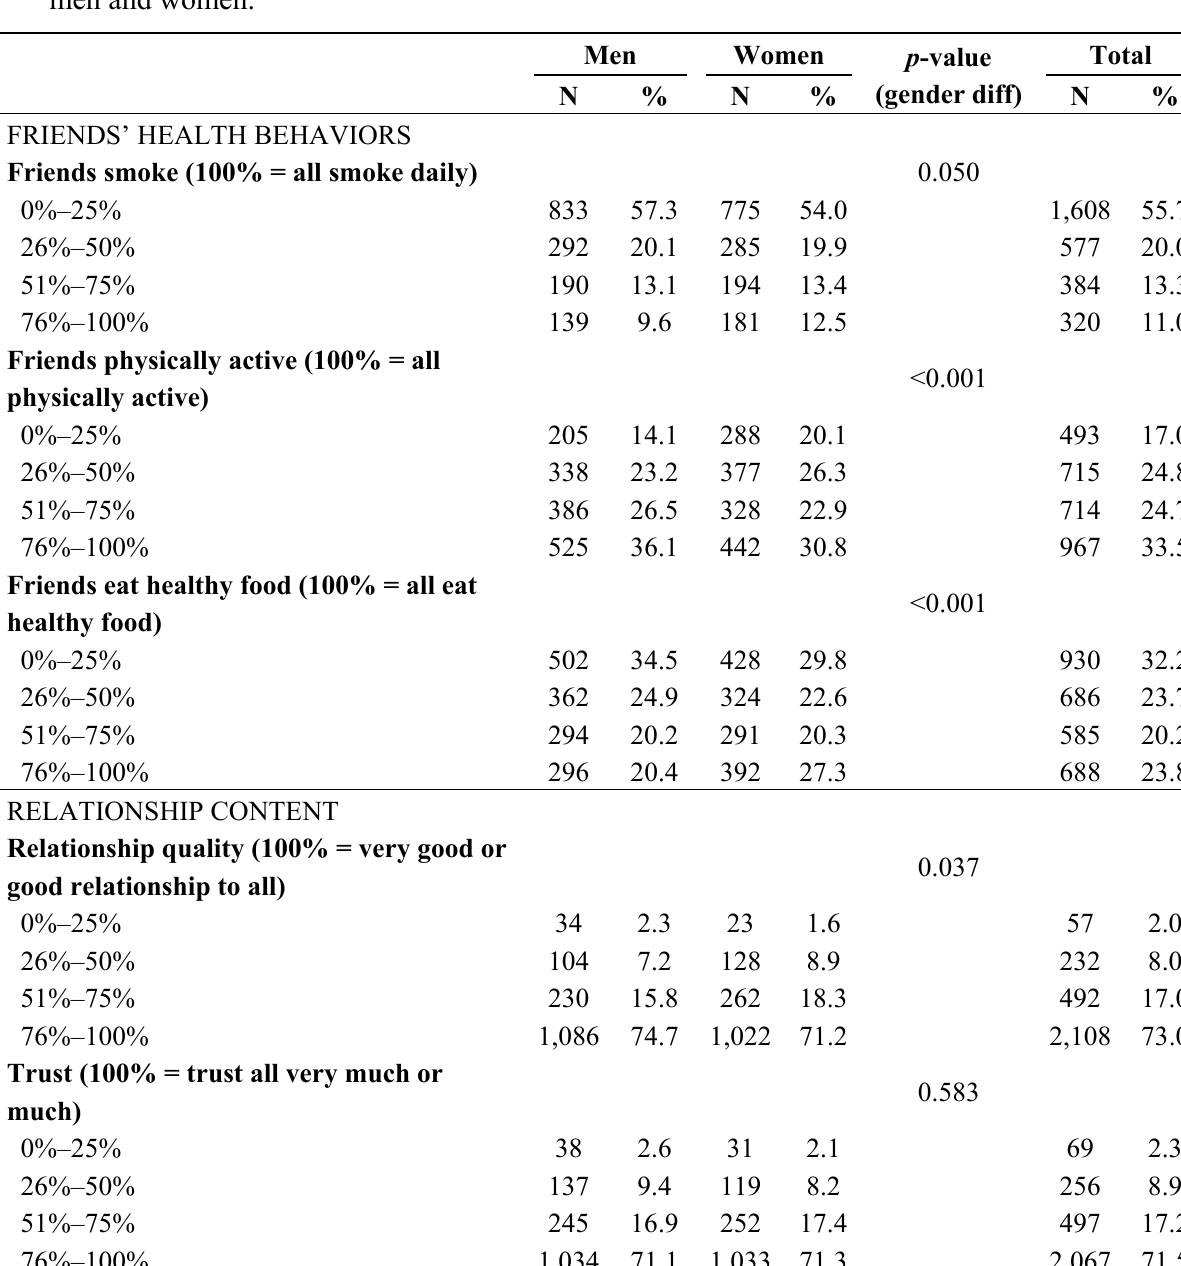
Table 2. Frequencies and percentage distribution by network characteristics, 19-year-old men and